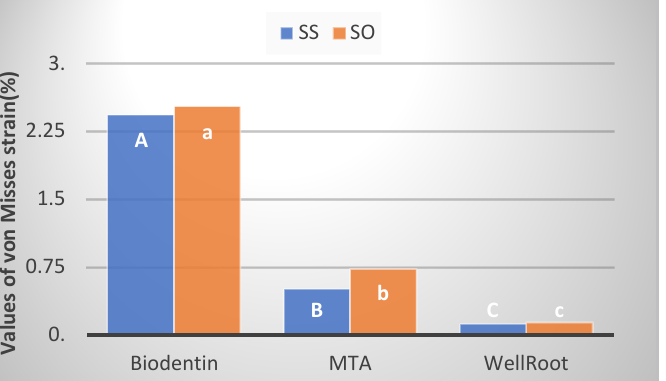
Figure 6. Bar chart shows mean values of von Mises strain in both zones, central (SS) and peripheral (SO), measured on dentine discs. Significant differences in the central zone are marked with different upper-case letters and those in the peripheral zone are marked with different lower-case letters.